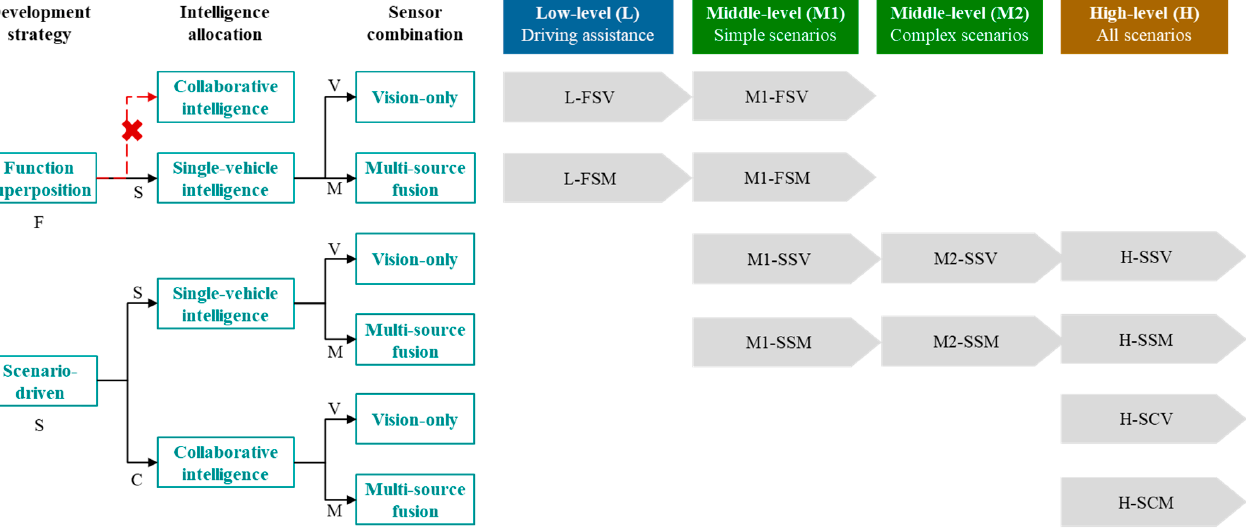
Table 1. Technical components of intelligent driving.